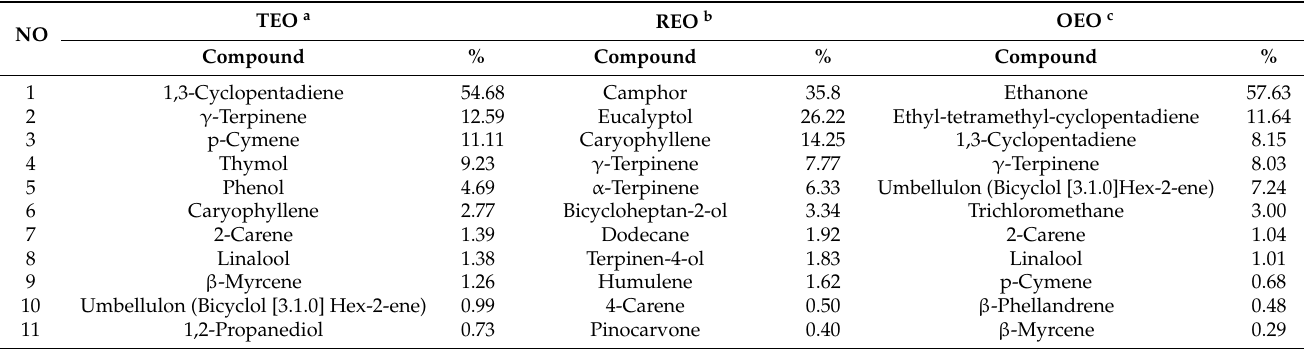
Table 10. Chemical composition of the studied essential